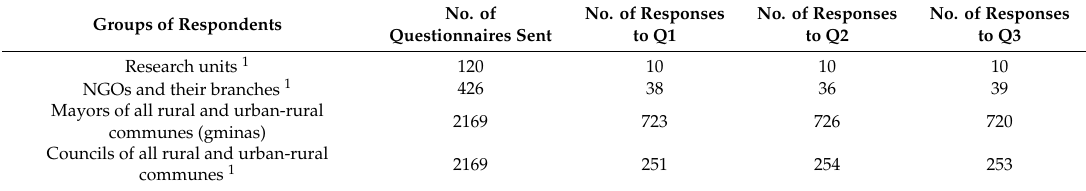
Table A1. Groups of stakeholders and numbers of responses to questions